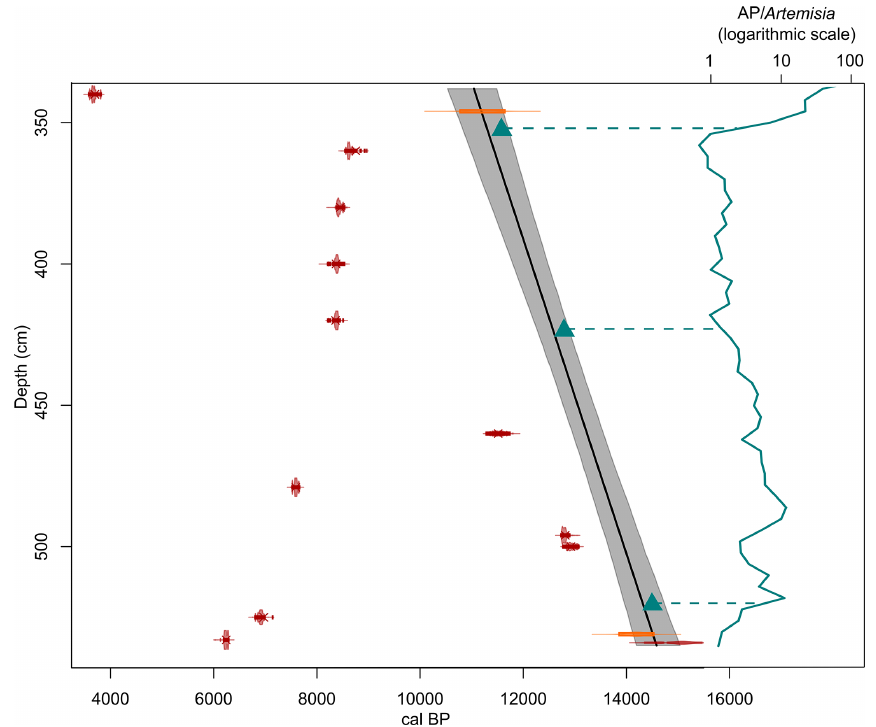
Figure 3. Age–depth model based on calibrated AMS radiocarbon dates (red points; Table 3) and tephra ages (orange points; Table 2). The gray band is the 95% confidence interval. Blue triangles are the median ages of the vegetation transition compiled with the regional pollen stratigraphy. This pollen stratigraphy includes the sites of Pavullo nel Frignano (Vescovi et al., 2010), Accesa (Drescher-Schneider et al., 2007), Albano (Mercuri et al., 2002), Mezzano (Sadori, 2018), Monticchio (Allen et al., 2002) and Trifoglietti (De Beaulieu et al., 2017). The AP / Artemisia ratio (blue line) is expressed on a logarithmic scale. AP stands for arboreal pollen. Table 2. Tephra samples from Matese cores (MC) and correlation with tephra samples from Lake Grande di Monticchio (Wulf et al., 2008) and proximal eruptive sources. Sample Depth MC (cm) Tephra